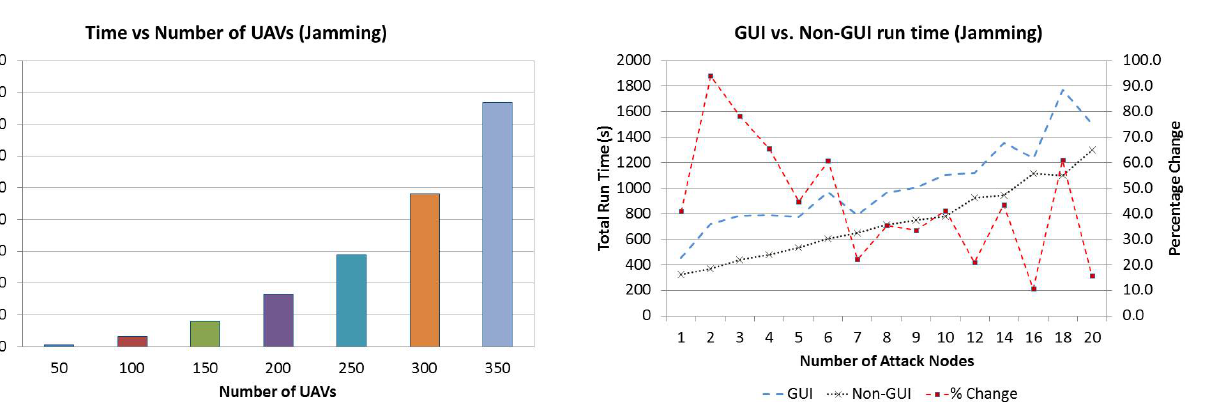
Figure 7. Run time variation with increasing number of UAVs for Jamming attack (different frequencies of hosts)